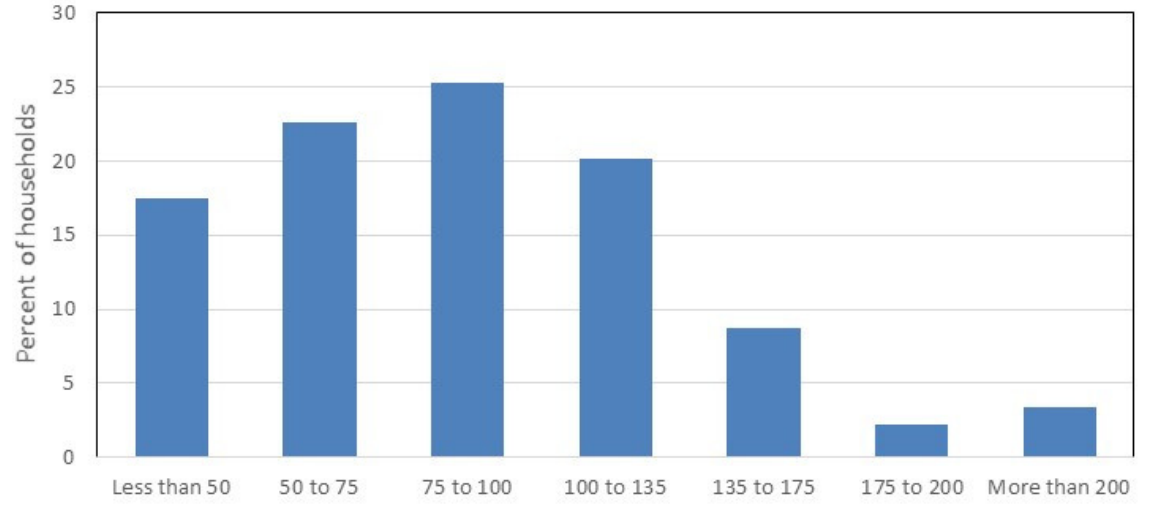
Figure 10. Daily water use in urban households varies widely, with 17% of households using less than 50 litres per capita, while 14% of households use more than 135 litres per capita.